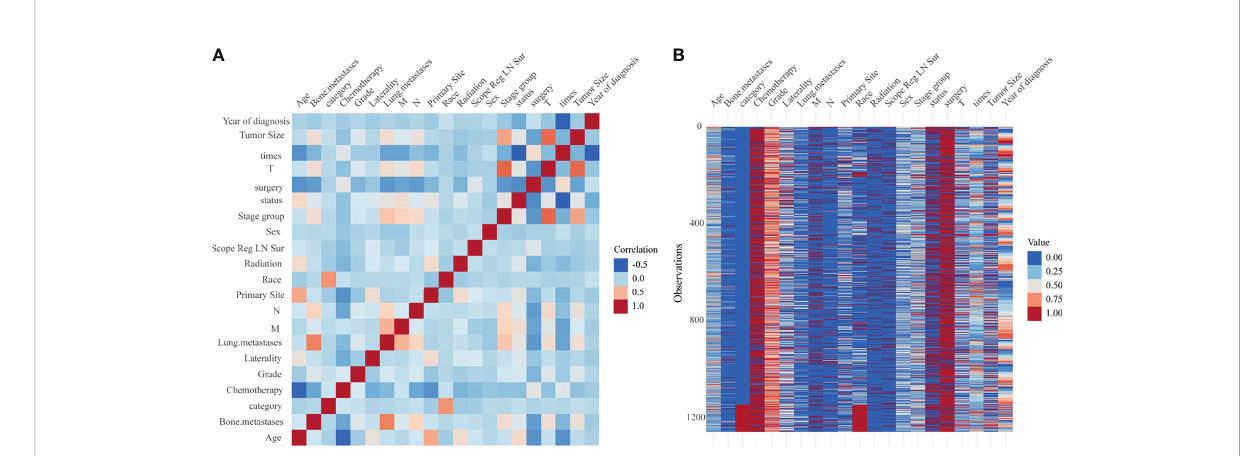
FIGURE 2 (A) Heat map of the correlation between each factor. (B) Heat map of the frequency in each